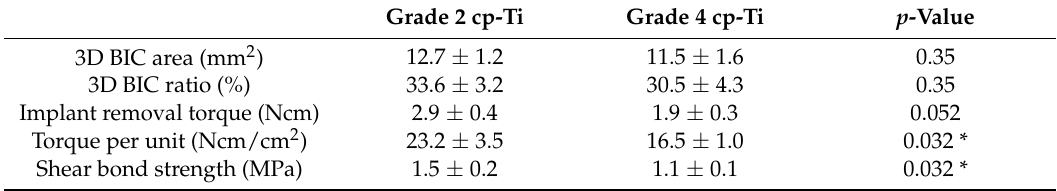
Table 2. Three-dimensional bone-to-implant contact (BIC) area and shear bond